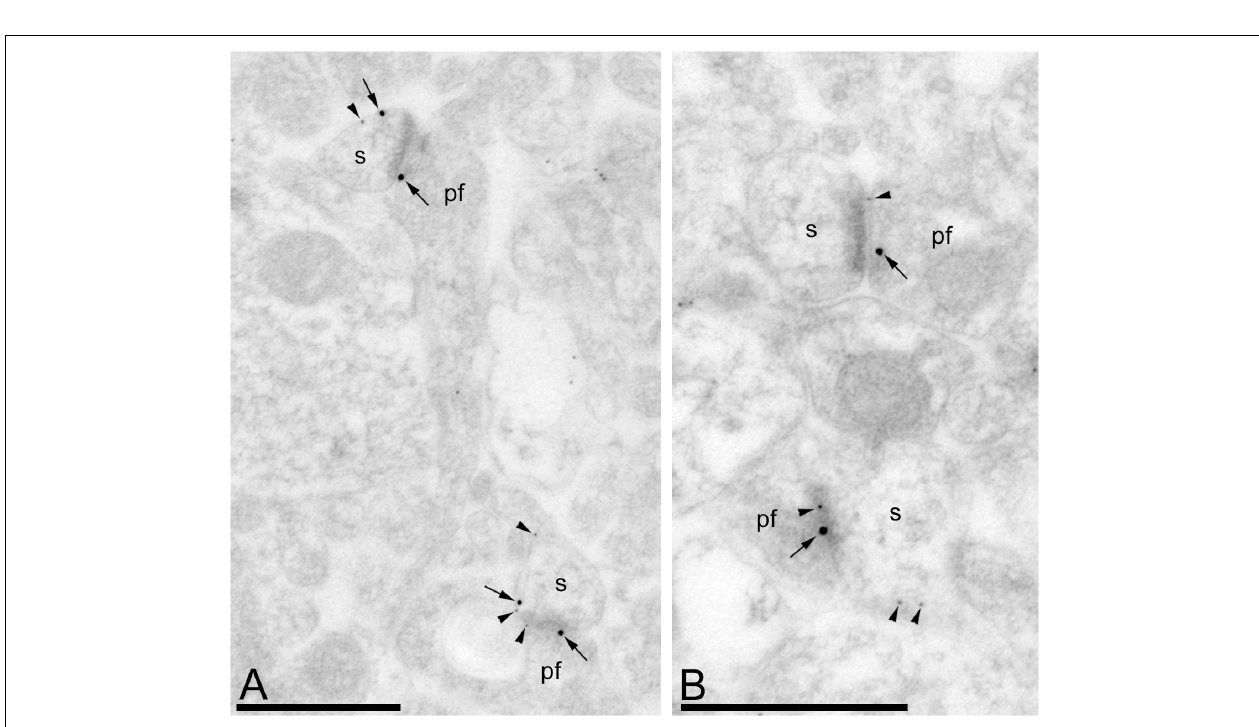
FIGURE 6 | G α o and GABA B 1 reside in the same dendritic spine of PCs. Electron micrographs of the molecular layer of the mouse cerebellar cortex showing immunoreactivity for G α o (10 nm particles, arrowheads) and GABA B 1 (20 nm particles, arrows), as detected using a double-labeling post-embedding immunogold method. G α o and GABA B 1 were observed at PSDs of excitatory synapses and extrasynaptic sites between PC spines (s) and parallel fibers (pf), many times very close to each other. Scale bars: (A,B) 500